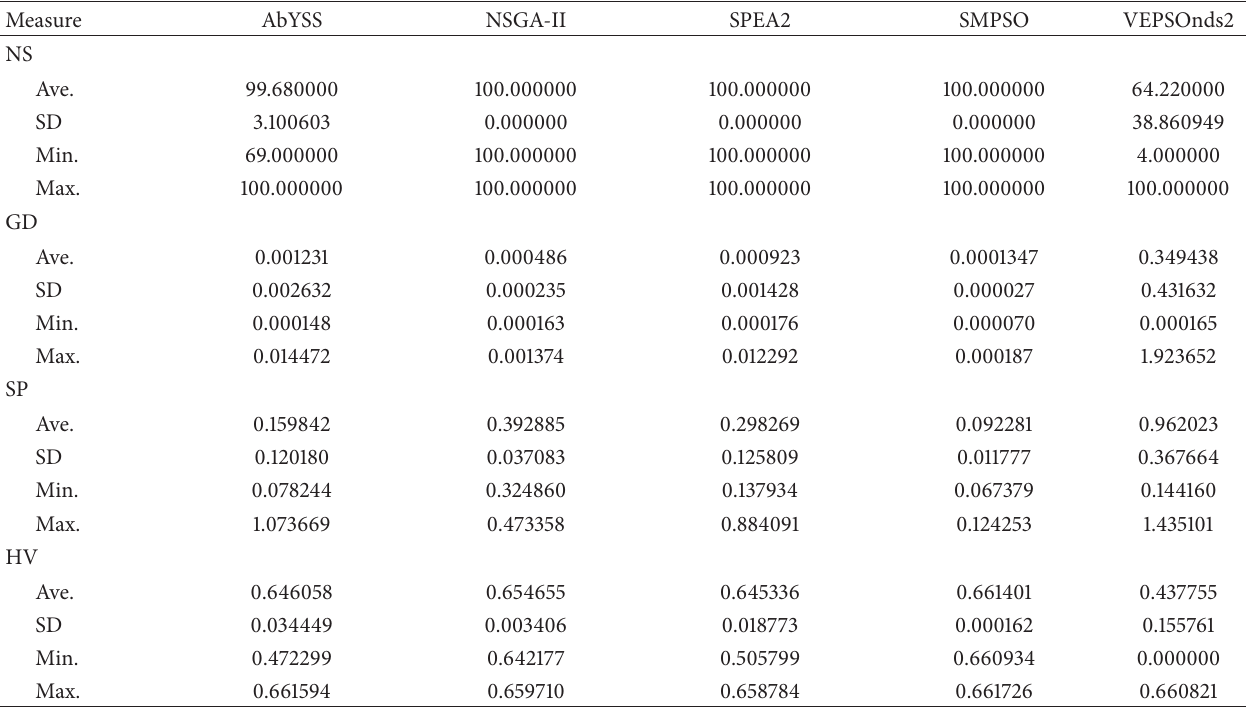
Table 9: Performance comparison based on ZDT4 test